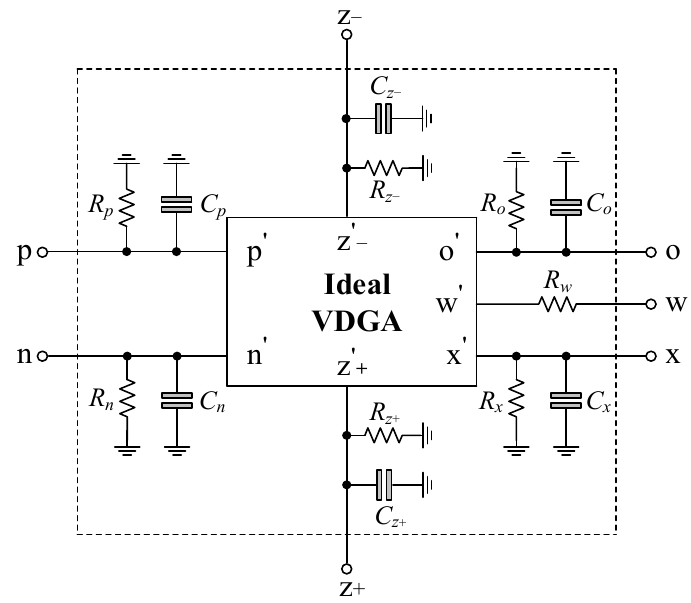
Figure 3. Equivalent circuit of the VDGA including various parasitic elements.